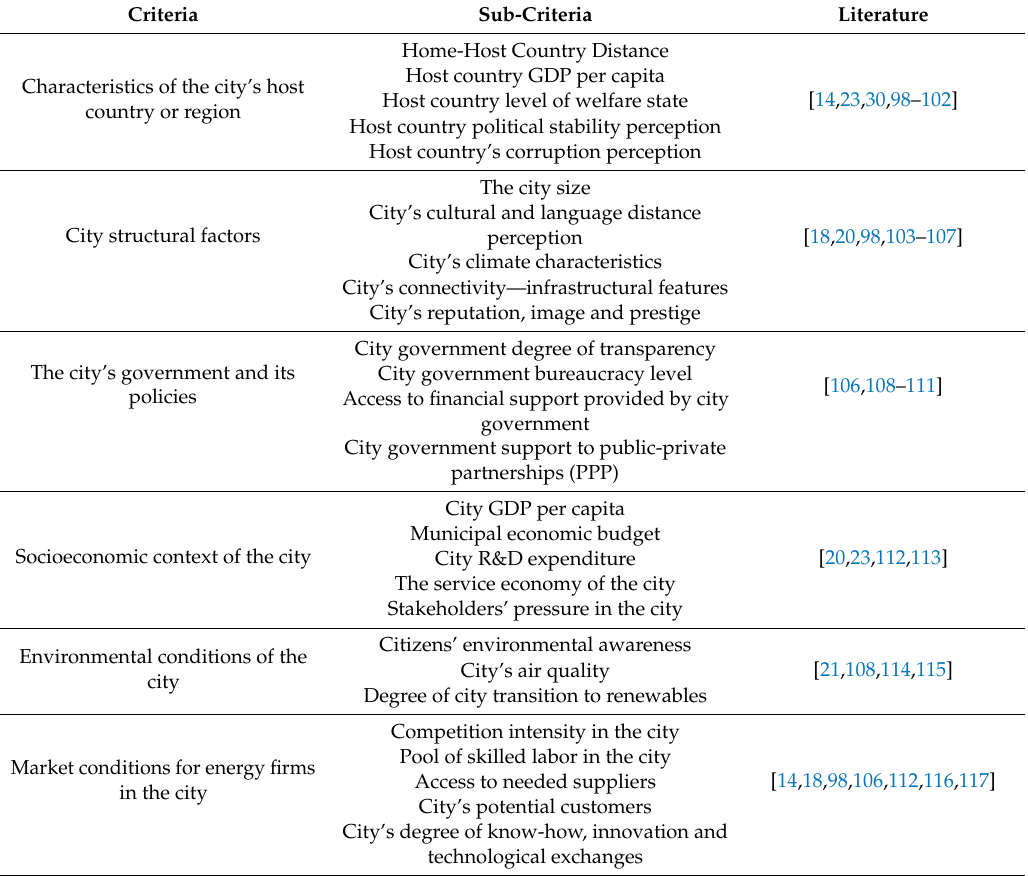
Figure 3. The AHP hierarchical framework for the European city selection problem of MNE in the energy sector. Table 2. List of relevant criteria and sub-criteria for location decisions in the energy MNEs